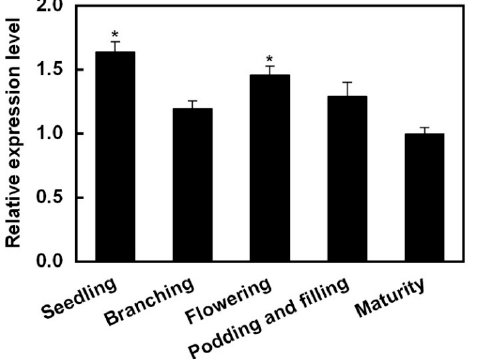
Figure 8. Relative expression of GmPLMT in soybean leaves at different developmental stages. Symbol “*” indicates the significant difference at p -value of 0.05 in comparison to the maturity stage.